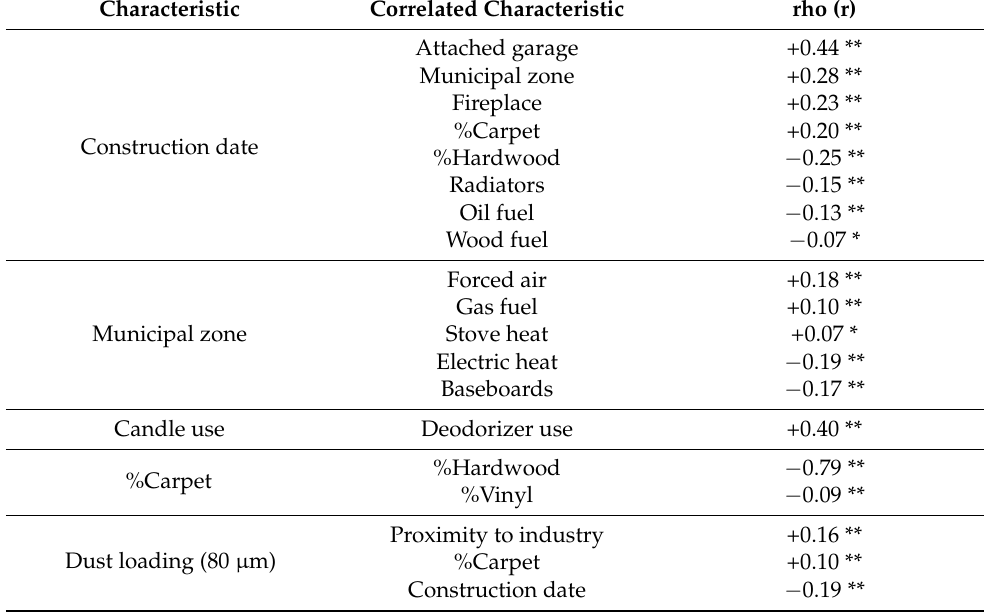
Table 3. Relationships between selected characteristics of Canadian House Dust Study homes ( n = 1025) identified using Spearman rank correlation analysis (** indicates p < 0.01; * indicates p < 0.05). No correlation was observed between construction date and proximity to industry; see SI-3 for all relationships between house characteristics.